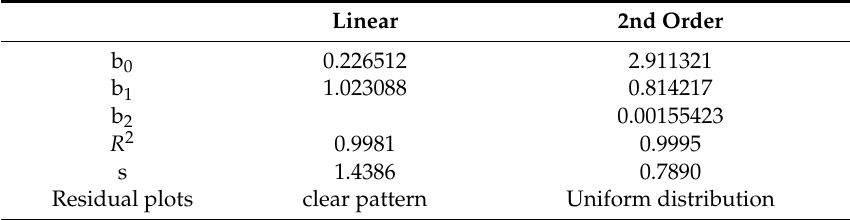
Table 8. Estimated parameters and evaluation criteria for the linear and polynomial equations for HMP 140A capacitive sensor using 5 salt solutions.